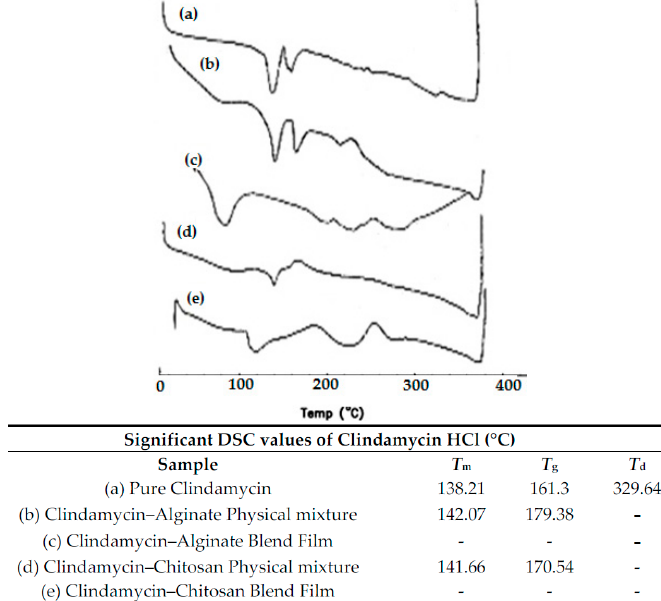
Figure 7. Significant data and DSC curves of (a) pure clindamycin; (b) clindamycin-alginate physical mixture; (c) clindamycin-alginate blend films; (d) clindamycin-chitosan physical mixture; (e) clindamycin-chitosan blend films.